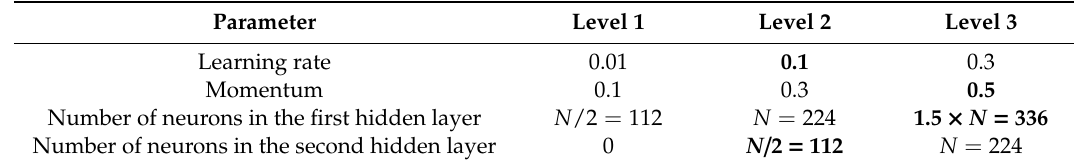
Table 3. Levels for the NARX neural network- based algorithm. Parameter Level 1 Level 2 Level 3 Learning rate 0.01 0.1 0.3 Momentum 0.1 0.3 0.5 Number of neurons in the first hidden layer N /2 = 112 N = 224 1.5 × N = 336 Number of neurons in the second hidden layer 0 N / 2 =